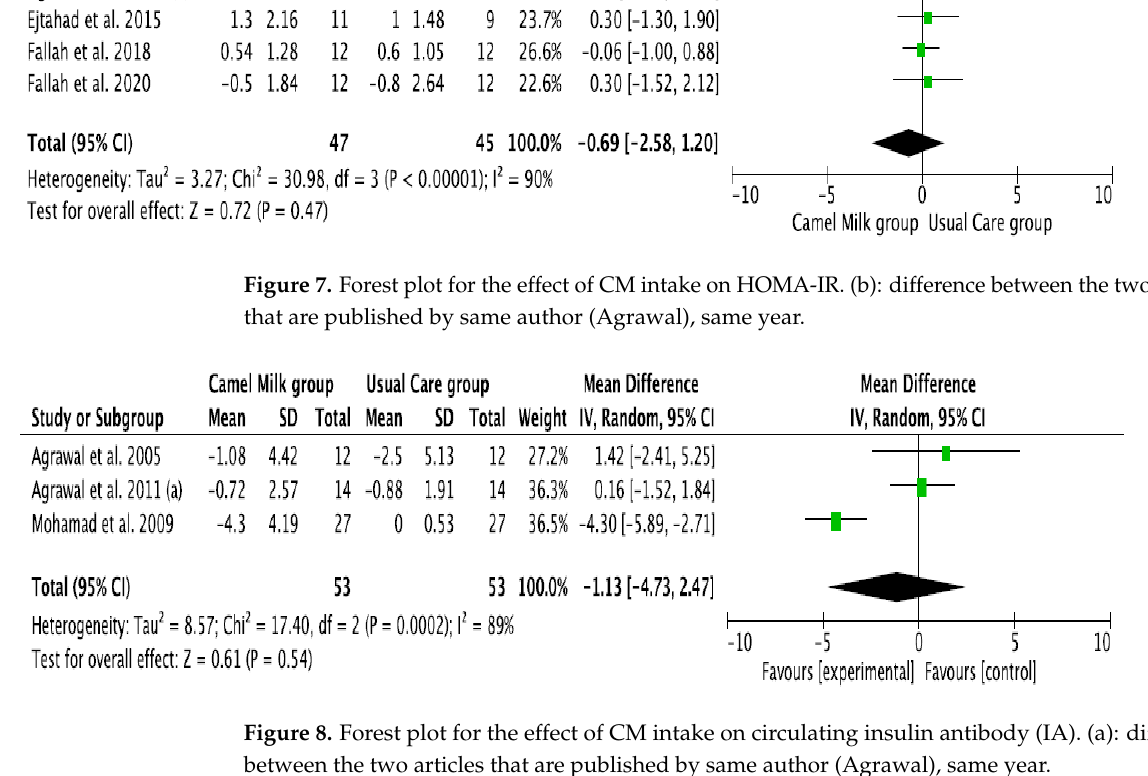
between the two articles that are published by same author (Agrawal), same year.